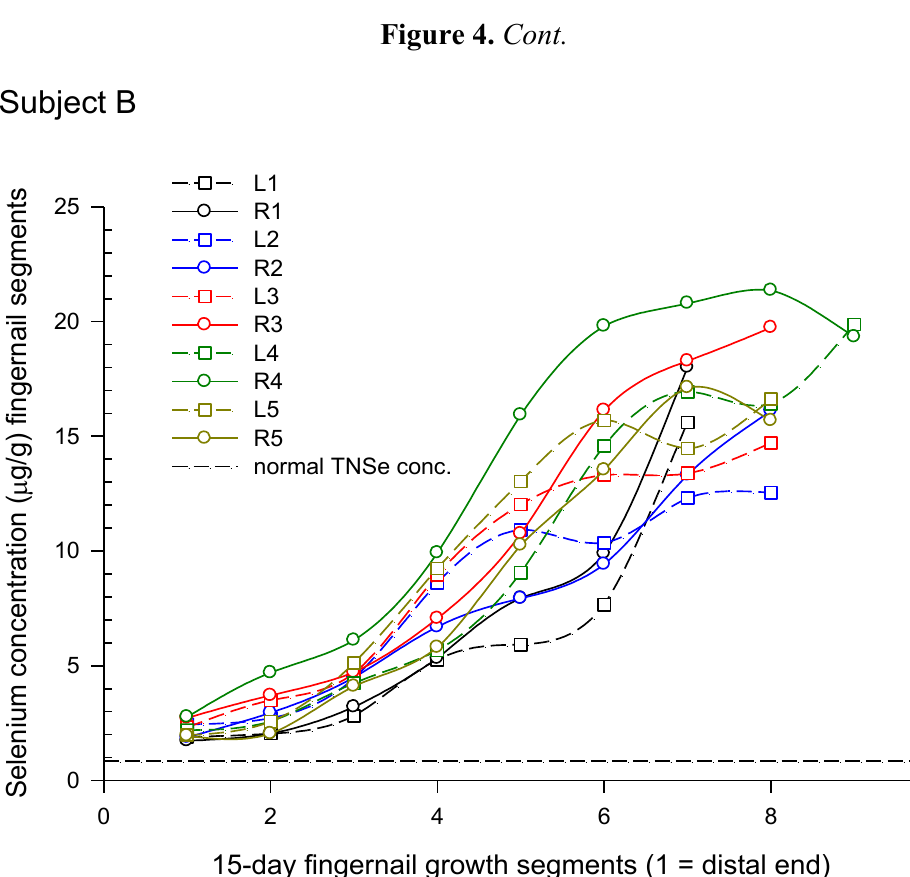
15-day fingernail growth segments (1 = distal